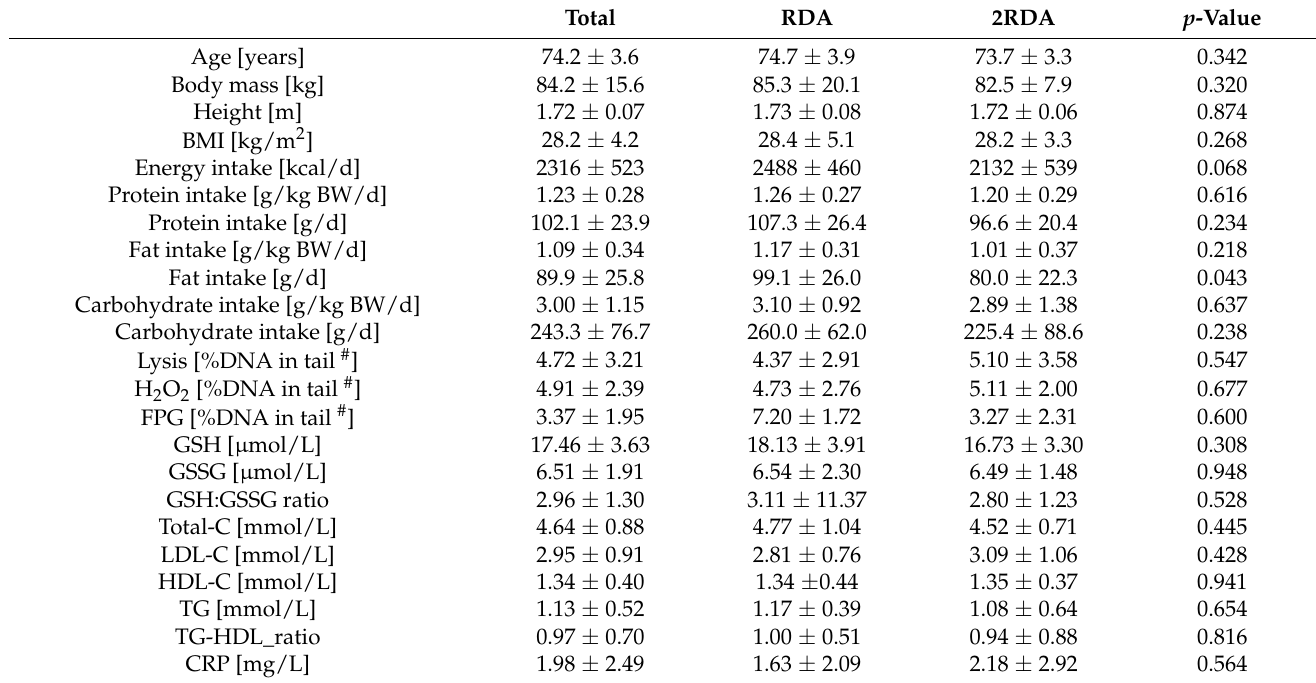
Table 2. Baseline characteristics and nutrient intake of the participants in the New Zealand